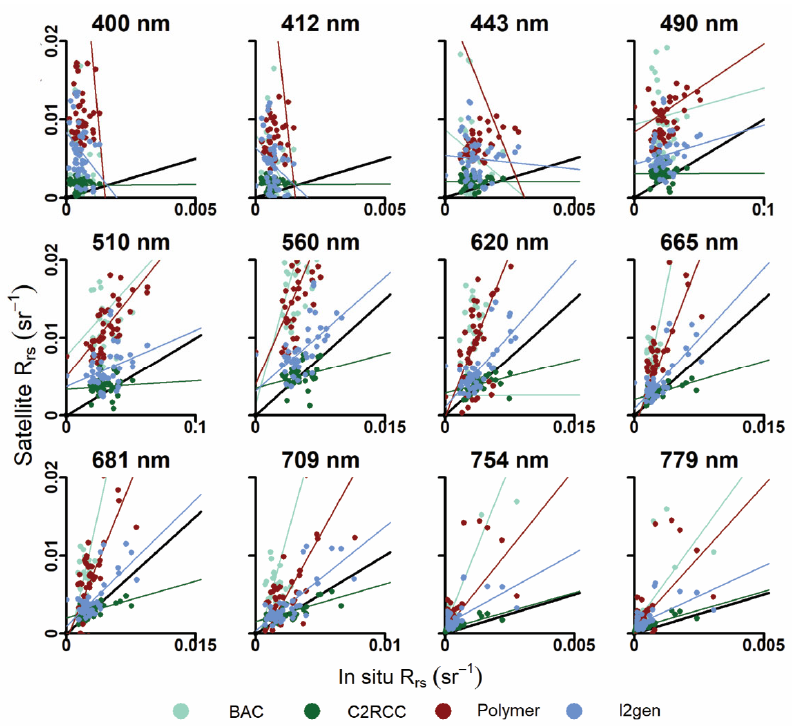
Figure 5. Scatter plots of in situ R rs vs. satellite-derived R rs for OLCI wavelengths ranging from 400 to 779 nm. The black line represents the 1:1 line and colored lines are linear regression fits for each atmospheric correction processor.